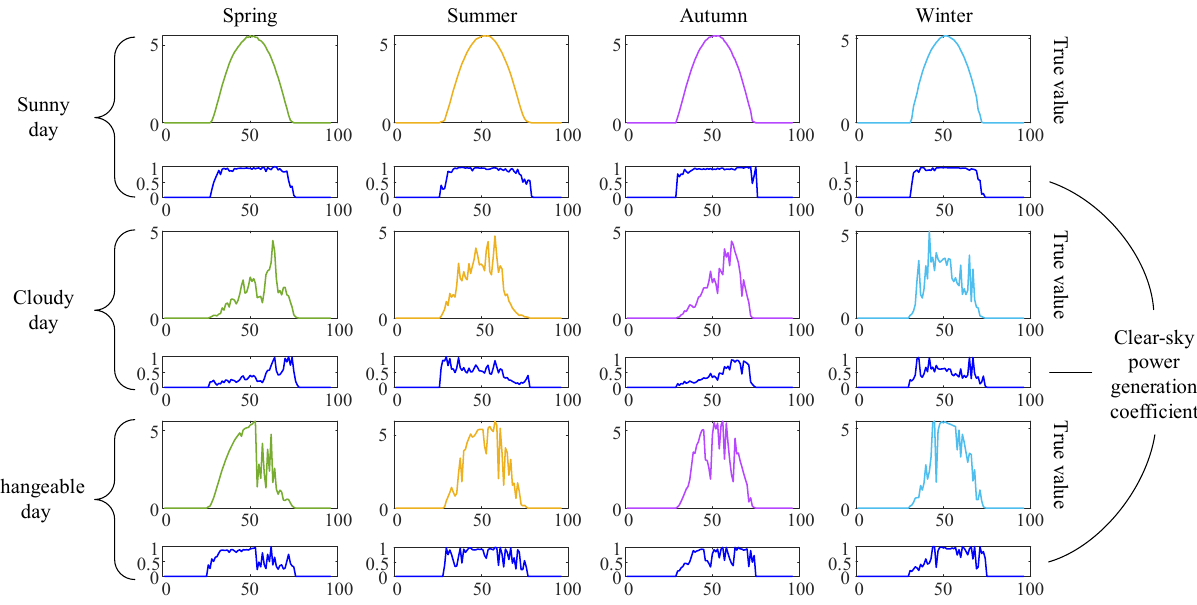
Figure 4. Comparison of the PV power and the CSPC for the sunny, cloudy, and changeable days for each season.